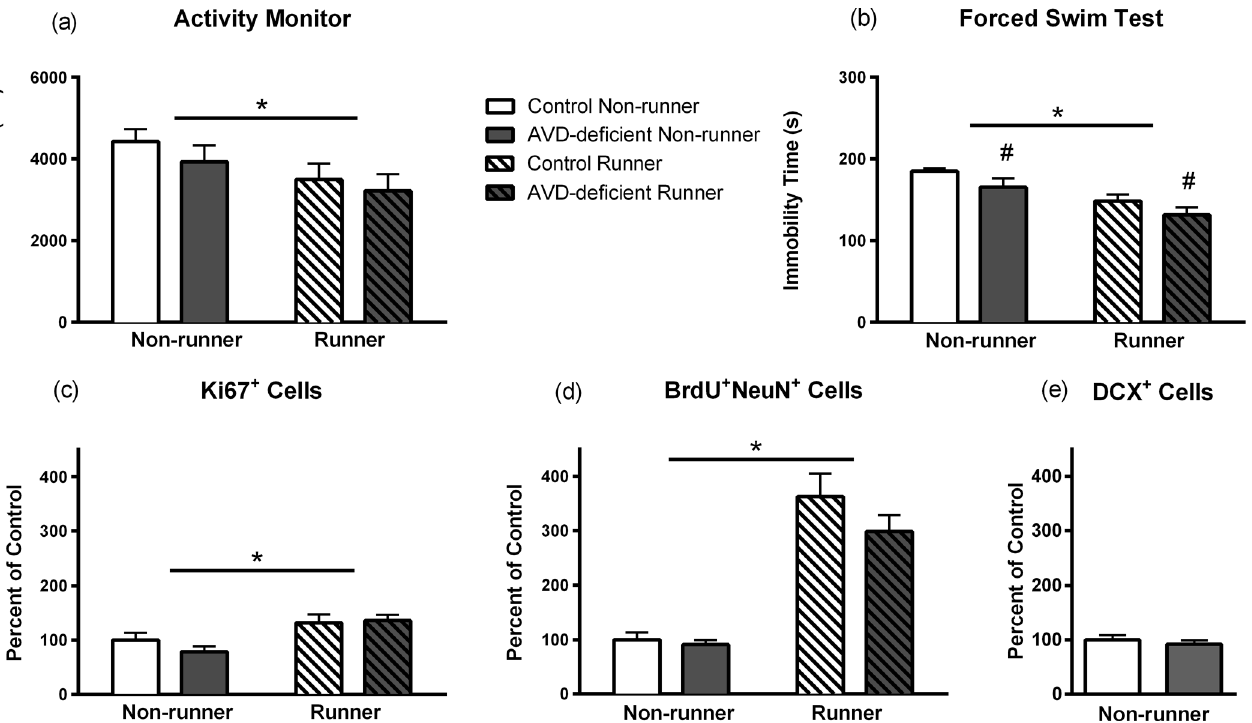
Fig 2. Results for the activity monitor, forced swim test (FST), and Ki67 + , BrdU + NeuN + , and DCX + cell counts. The distance travelled in the activity monitors is shown in (a) ( n = 13 – 15 per group). There was no significant effect of Diet but there was a significant main effect of Running. Runners moved less than Non-runners. Immobility time during the FST is shown in (b) ( n = 7 – 8 per group). There was a main effect of both Diet and Running. Wheel running significantly reduced immobility time; moreover AVD deficiency also reduced immobility time. The number of Ki67 + is shown expressed as a percent of control non-runner values (c) ( n = 8 per group). There was no significant effect of diet but there was a significant effect of Running. Runners had higher numbers of Ki67 + cells compared to Non-runners. There was no significant difference between control and AVD-deficient mice. BrdU + NeuN + cell counts expressed as a percent of control non-runner values is shown in (d) ( n = 8 per group). There was a significant increase in the number of BrdU + NeuN + cells following voluntary running. However, there was no significant effect of Diet on baseline cell numbers or cell numbers stimulated by voluntary running. The number of DCX expressed as a percent of control non-runner values is shown in (e) ( n = 7 per group). Where main effect is significant, p-value is given on graph. Mean ± SEM ( * p < 0.05).